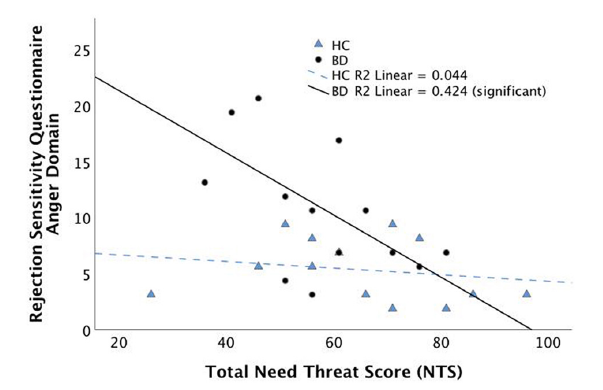
FIGURE 1 | Spearman’s correlation between subjective distress during social exclusion (as measured by the Need Threat Scale) and the anger domain of the Rejection Sensitivity Questionnaire (RSQ). Correlation is significant within the Bipolar Disorder group but not the Healthy Control group.